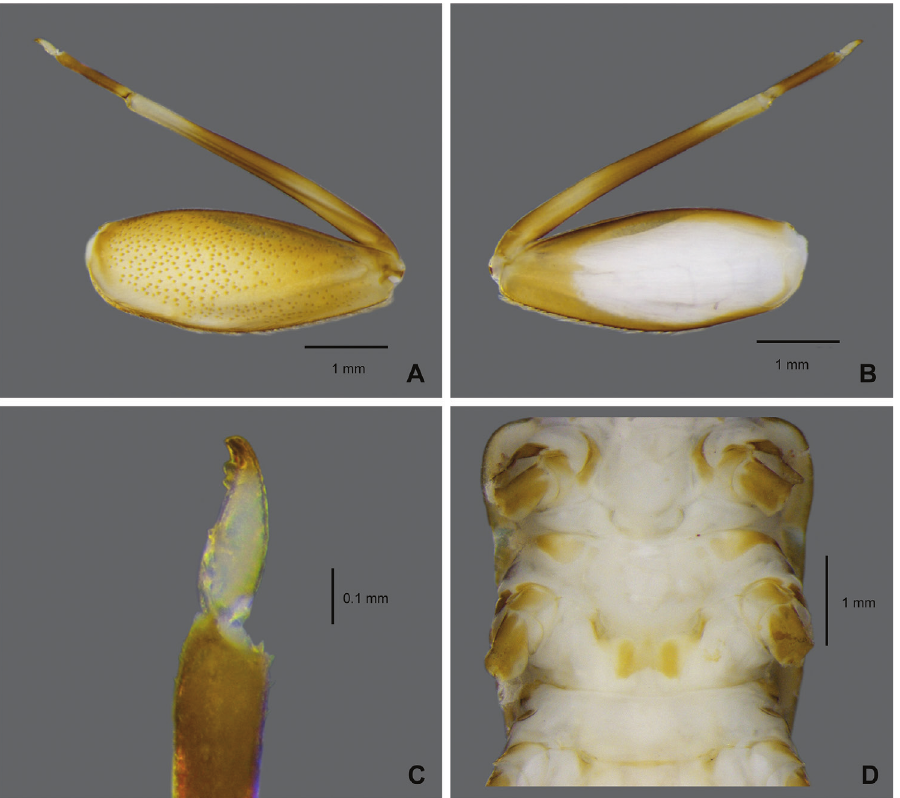
Figure 4. Paegniodes sapanensis sp. nov., larval morphology A foreleg (dorsal view) B foreleg (ventral view) C tarsal claw of foreleg D